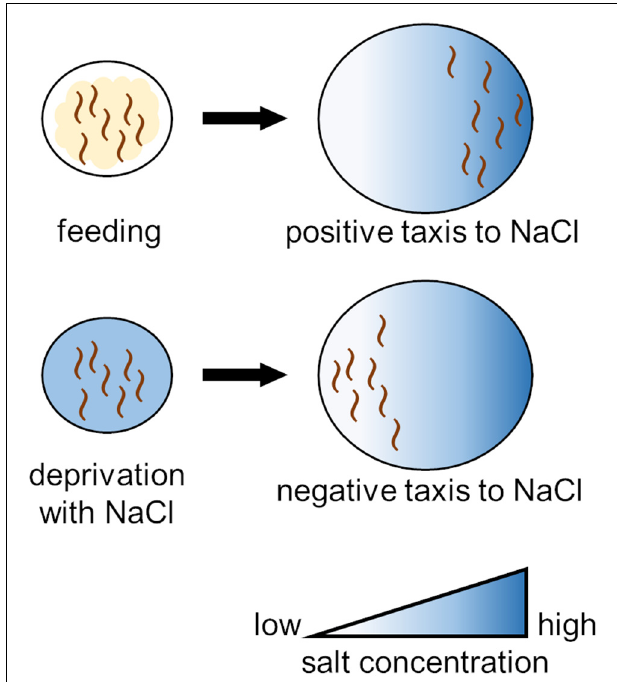
FIGURE 2 | Training protocol for salt chemotaxis learning in C. elegans . Worms exhibit positive chemotaxis (attraction behavior) to NaCl under normal conditions, whereas worms subjected to prolonged exposure to NaCl under starvation conditions exhibit negative chemotaxis (avoidance behavior) to